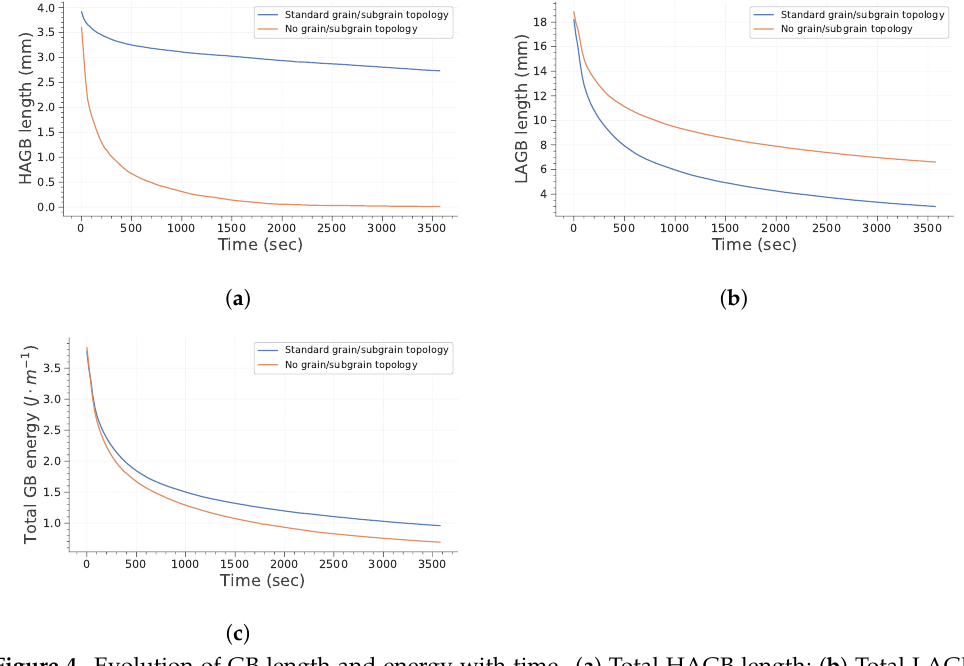
Figure 4. Evolution of GB length and energy with time. ( a ) Total HAGB length; ( b ) Total LAGB length; ( c ) Total GB